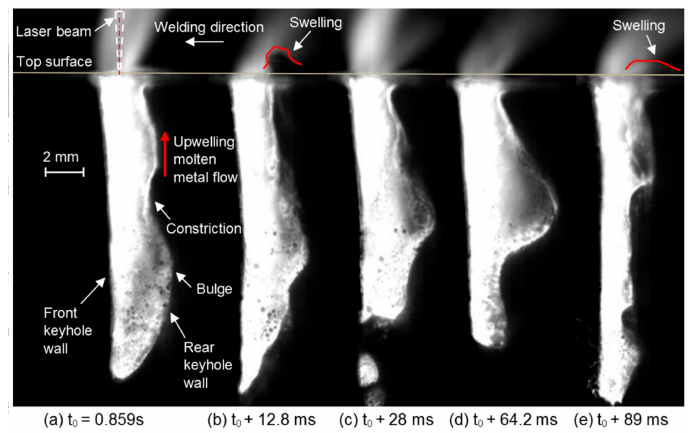
Figure 8. Images of the longitudinal keyhole and vapor plume in the vertical welding (p = 10 kW, v = 1.8 m/min, ∆ = +10